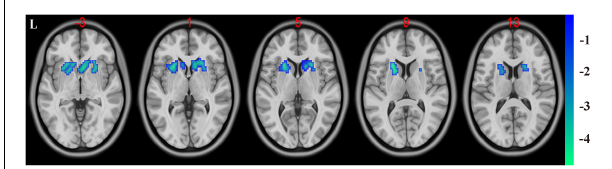
FIGURE 2 | Decreased functional connectivity between the bilateral caudate (defined as seed) and bilateral putamen and caudate. A P -value lower than 0.001 ( P < 0.001) combined with cluster size larger than 110 voxels was considered as statistically significant (cluster-level false discovery rate corrected). Color bar indicated t -value between hemodialysis and healthy control groups.